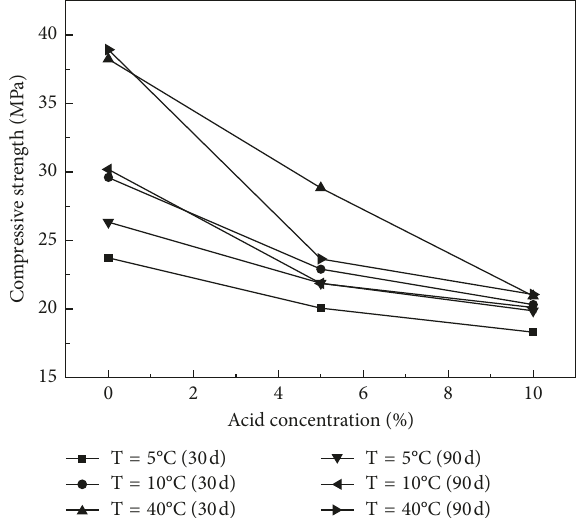
Figure 4: Variation of compressive strengths of concrete speci- mens with acid concentration.